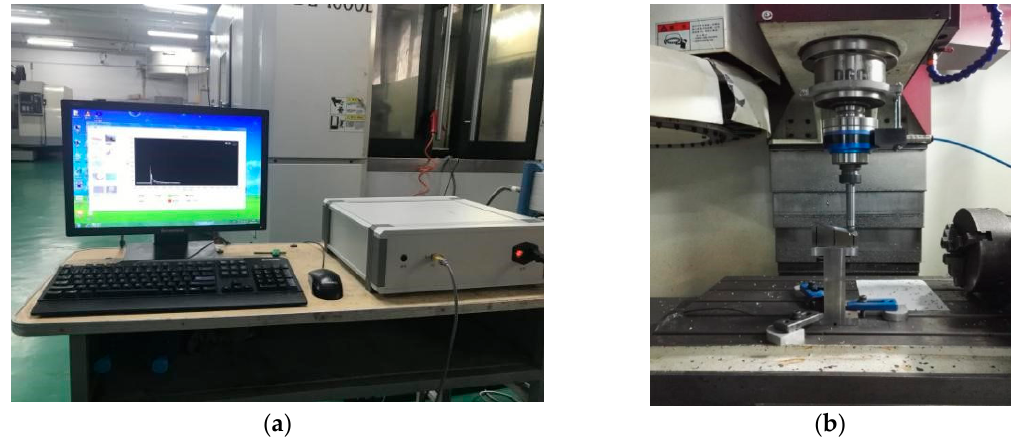
Figure 9. Experimental setup diagram. ( a ) Milling temperature acquisition system. ( b ) Workpiece clamping diagram.